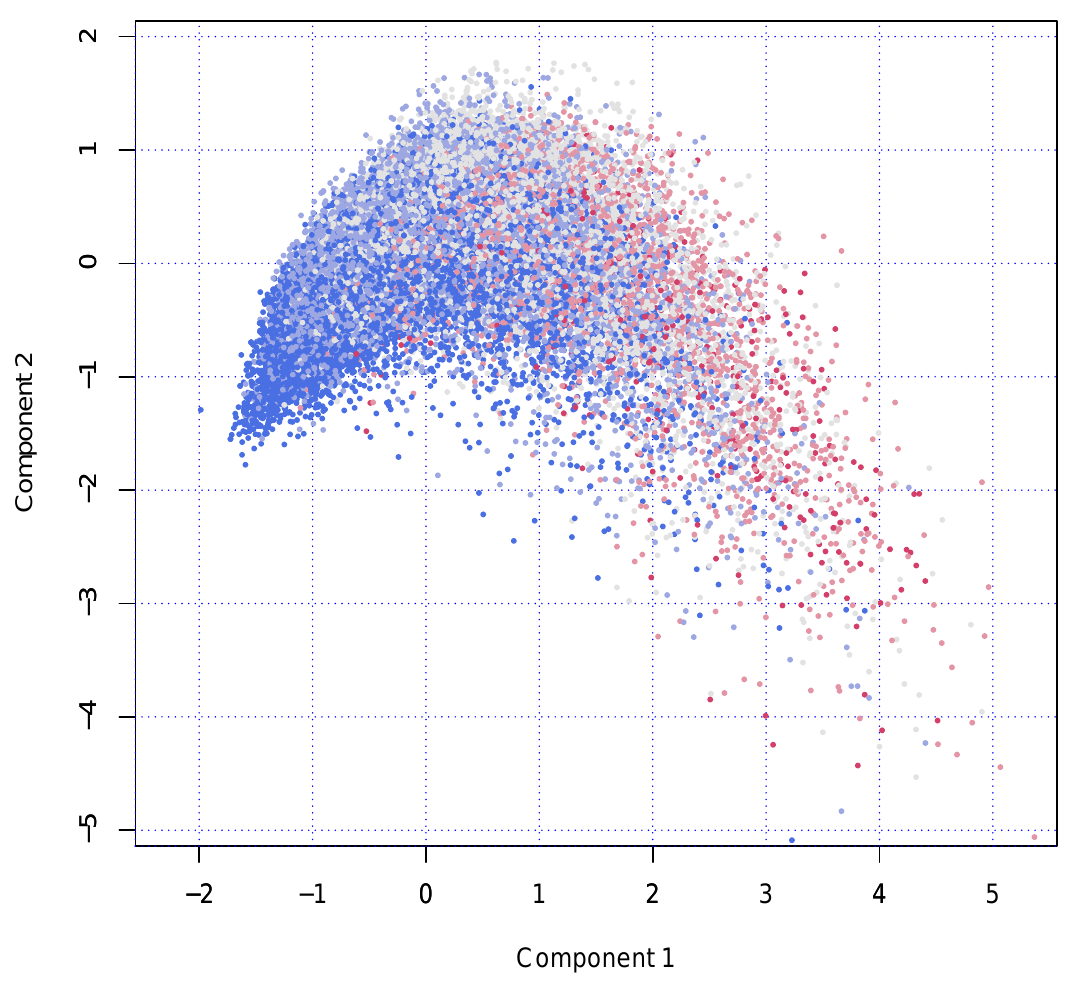
Figure 1. The locations of 44,285 elderly persons on the first two principal components.